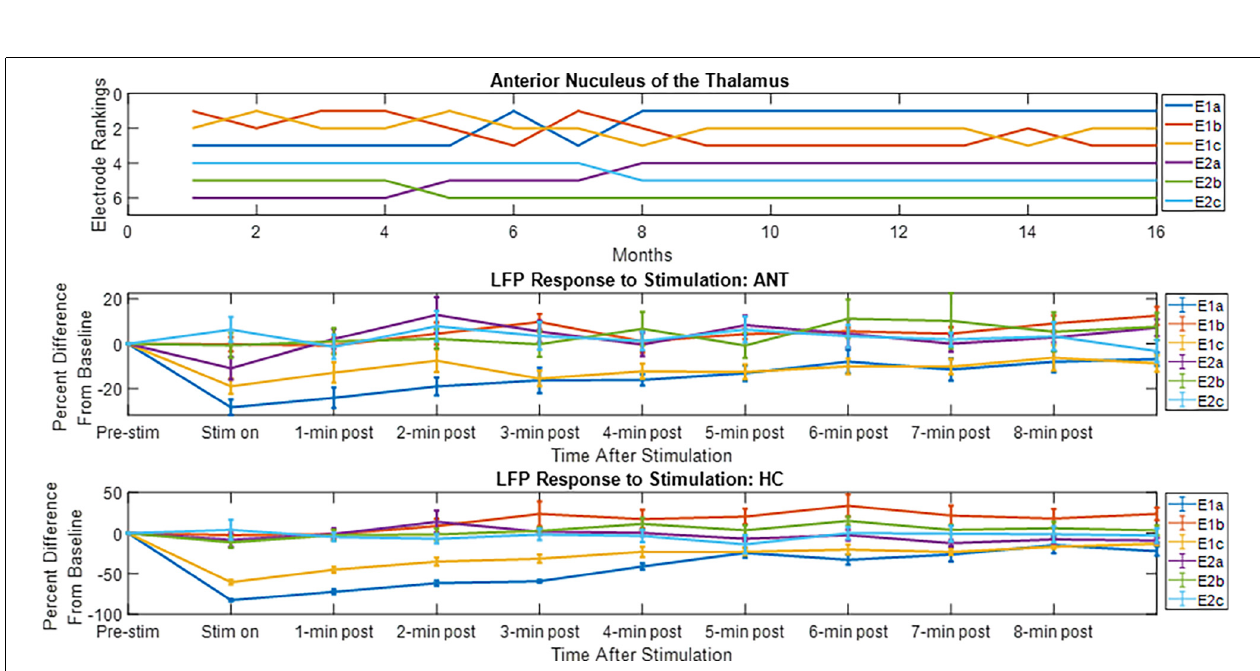
FIGURE 7 | Electrode rankings and the LFP response to thalamic stimulation. For the electrode rankings, in-person monitors took place between weeks 9 and 16 and remote monitors took place between weeks 1 and 9. For the LFP response to stimulation, the LFP response compared to baseline is plotted for the duration of the recordings. The average response and standard error are displayed. For the local response in the AN and for the network response in the HC, the top-ranked electrodes corresponded with the electrodes that had an observable decrease in LFP activity after stimulation.